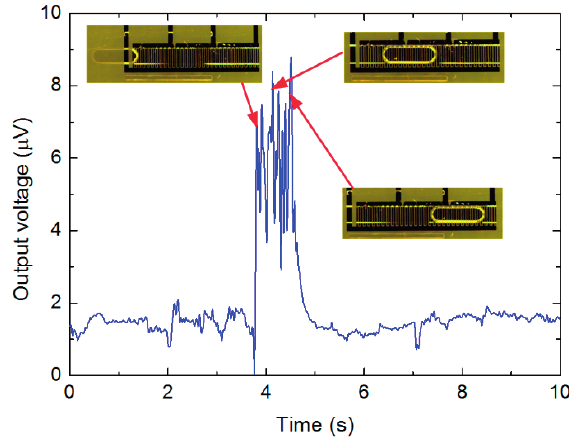
Figure 8. Voltage variation measured with a water droplet 2.1 mm long in continuous oil (flow direction from left to the right), by use of three connections (water flow-rate at 0.007 mL/min and oil flow-rate at 0.003